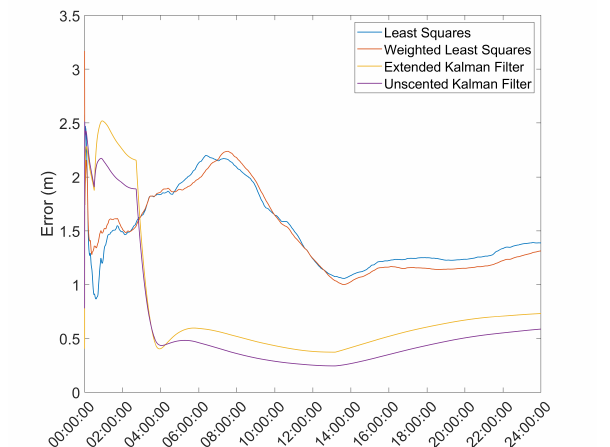
Figure 4. Mean error variation over time for the base station antenna with Hatch Filter and γ = 0.010.